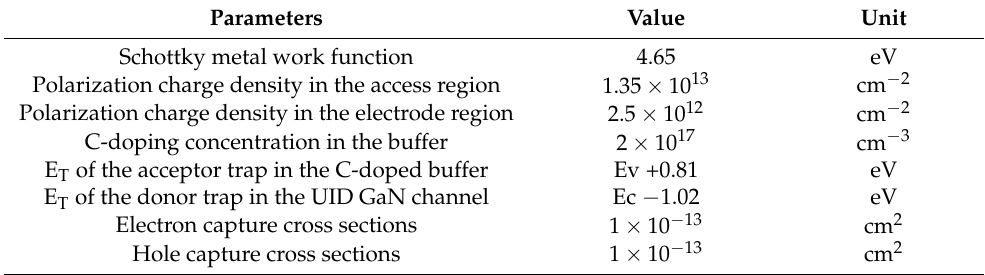
Table 1. Parameters utilized in the